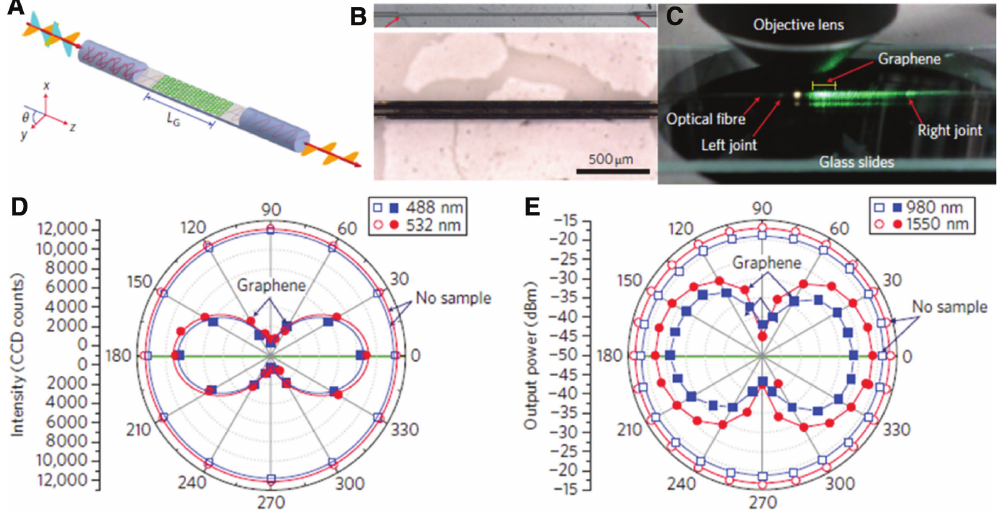
Figure 20: Broadband graphene polarizer. (A) Schematic model of fiber-to-graphene coupler based on a side-polished optical fiber. L microfiber and microfiber incorporating graphene. (C) Polarized diagram of the laser beam along s and p polarization. (D) Polar diagram at 488 and 532 nm, respectively. (E) Polar diagram at 980 and 1550 nm, respectively. Reproduced with permission from Ref. [457]. Copyright 2011, Springer